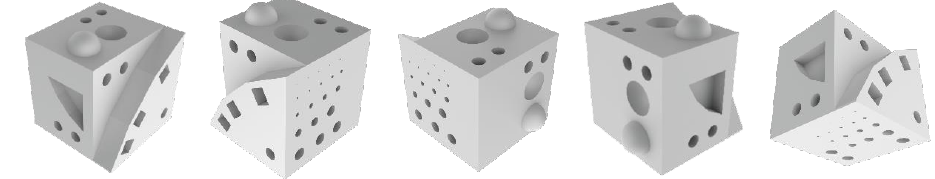
Figure 1. CAD Illustration of Sample to be Manufactured. Views of its different faces.